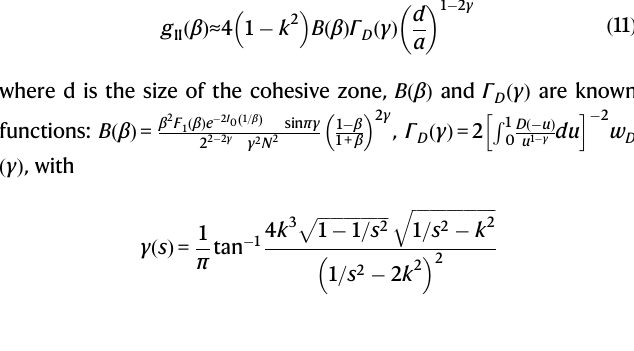
ffiffiffiffiffiffiffiffiffiffiffiffiffiffiffiffiffi p 1 (cid:2) 1 = s 2